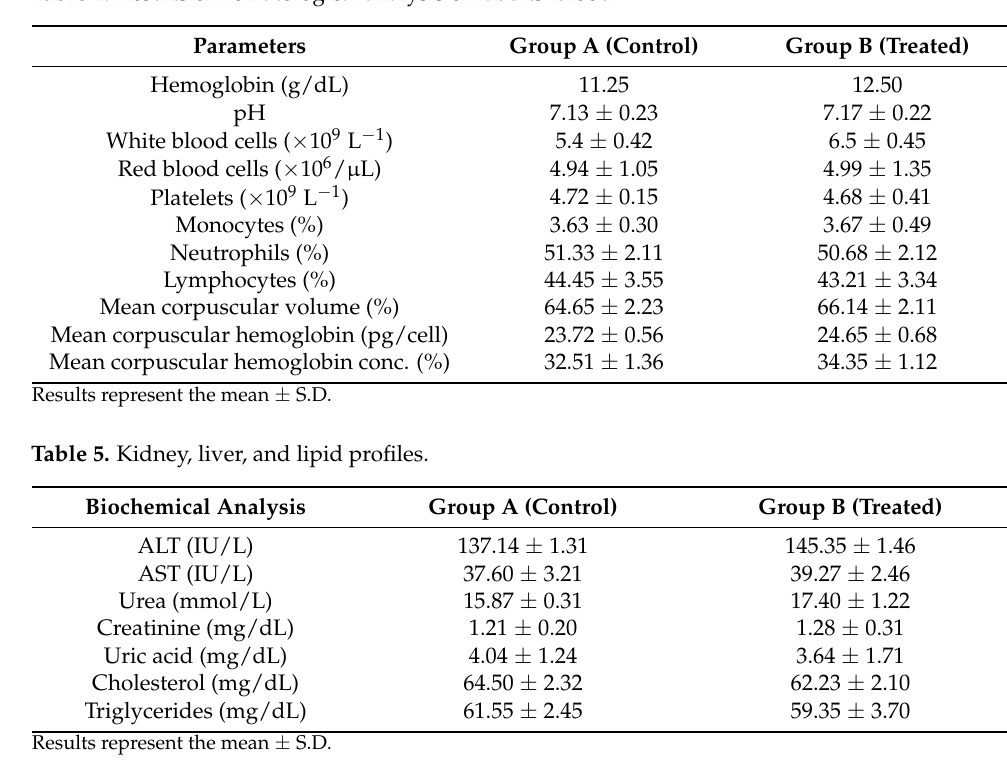
Table 4. Results of hematological analysis of rabbits’ blood.